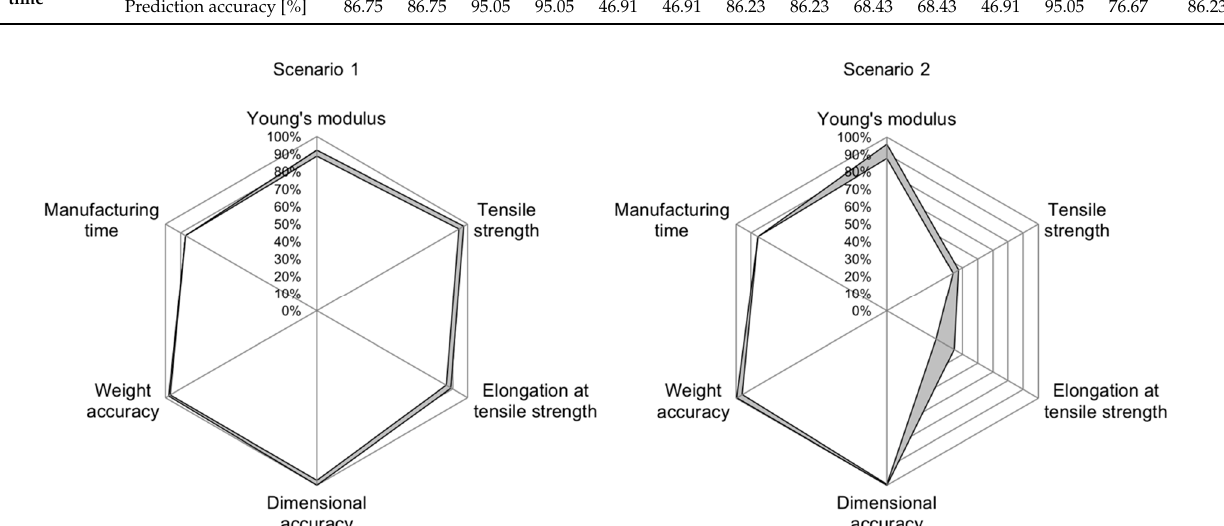
Figure 7. Radar chart for input accuracies in scenarios 1 ( left ) and 2 ( right ). The gray band shows the interval between best and worst accuracy for each quality characteristic.